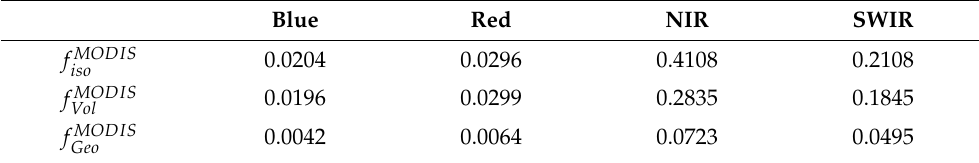
Table 1. BRDF parameters used for the